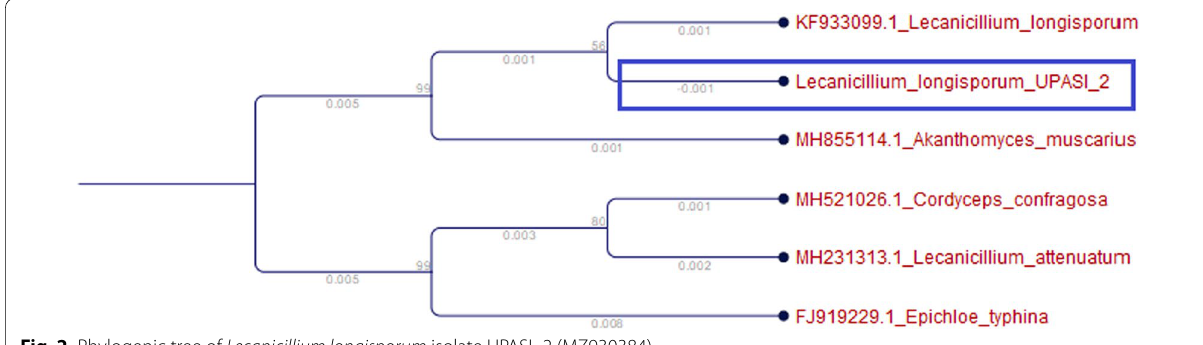
Fig. 2 Phylogenic tree of Lecanicillium longisporum isolate UPASI_2 (MZ930384)